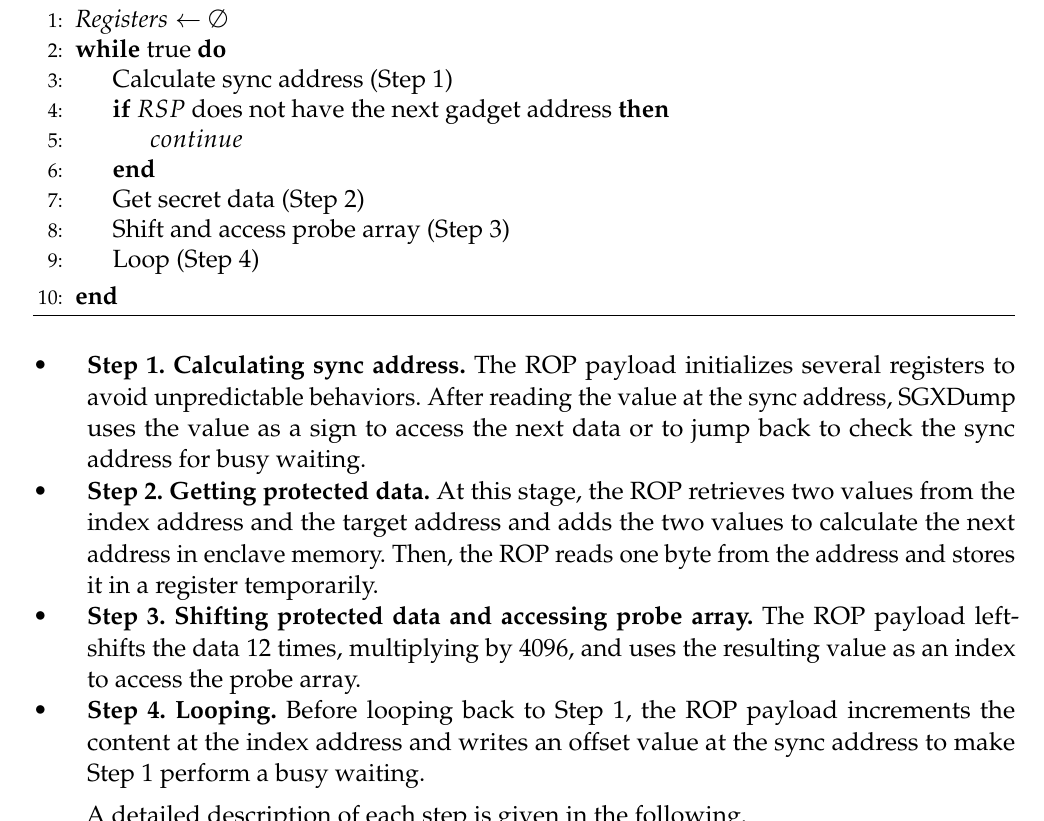
Algorithm 1 Flow of ROP